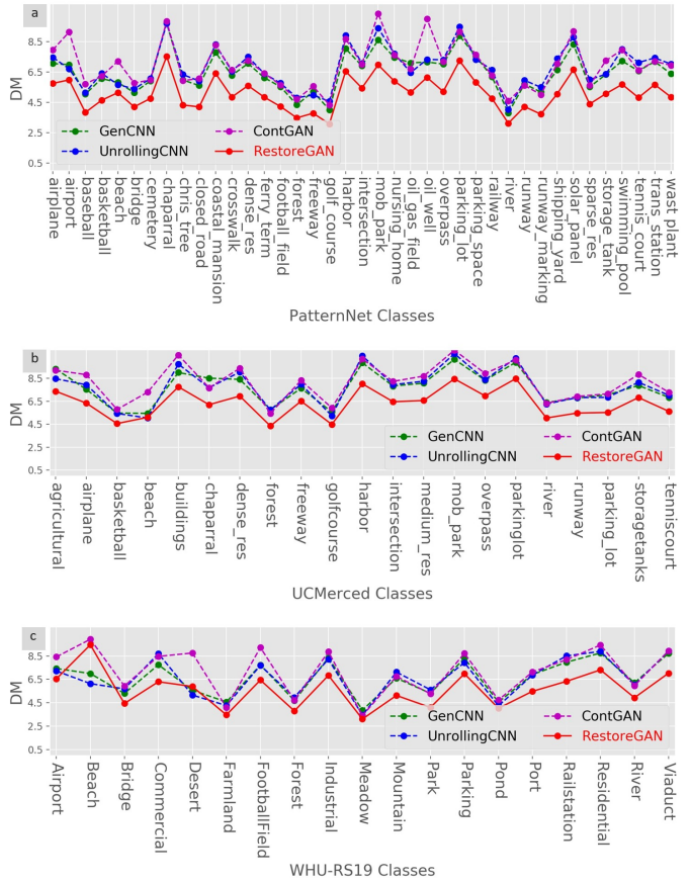
Figure 8. Restoration results of different methods on the three datasets. ( a ): DM results on the Pat- ternNet dataset; ( b ): DM results on the UCMerced dataset; ( c ): DM results on the WHU-RS19